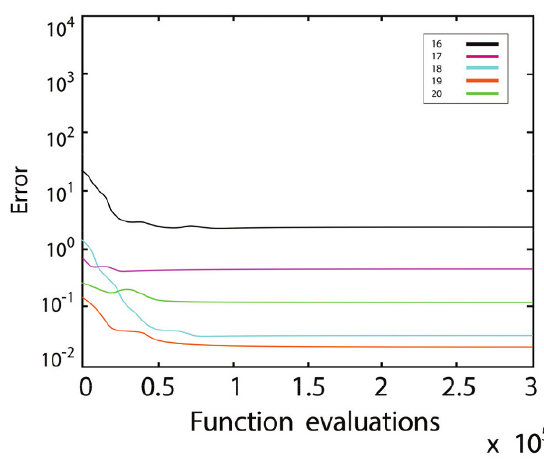
Figure 13. The results of applying the MSCA on F 16 – F 20 (Conver- gence of Functions F 16 – F 20 ).